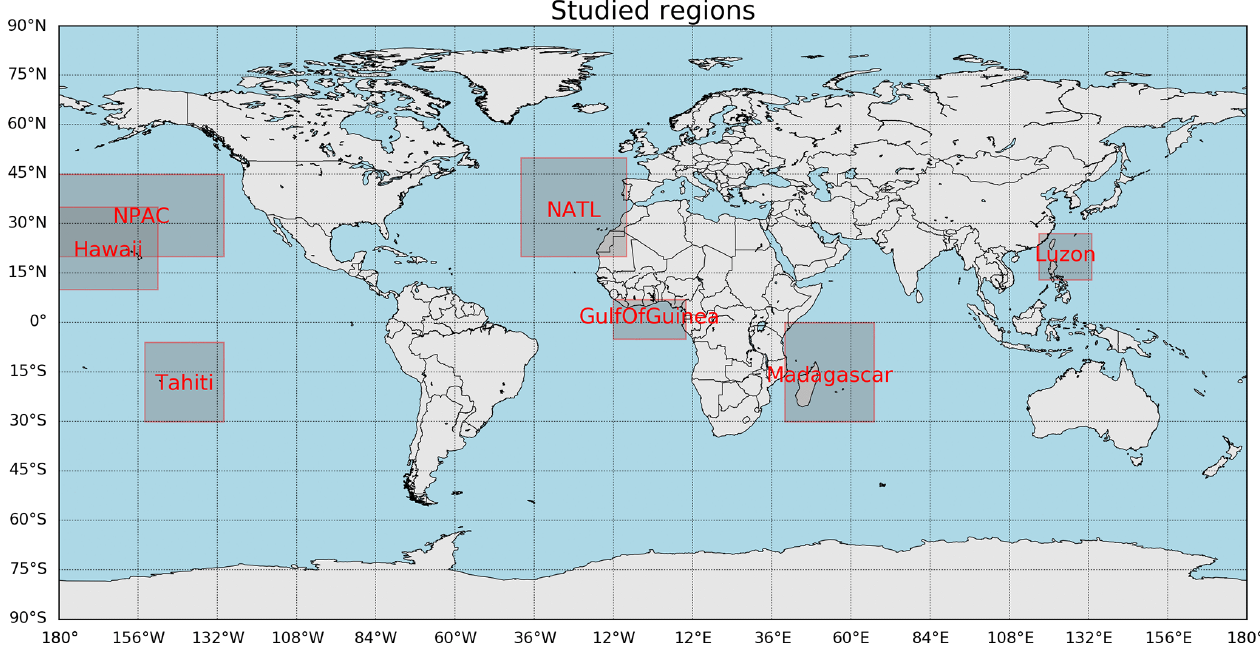
Figure 1. Localization of the internal-tide regions studied in the present paper.